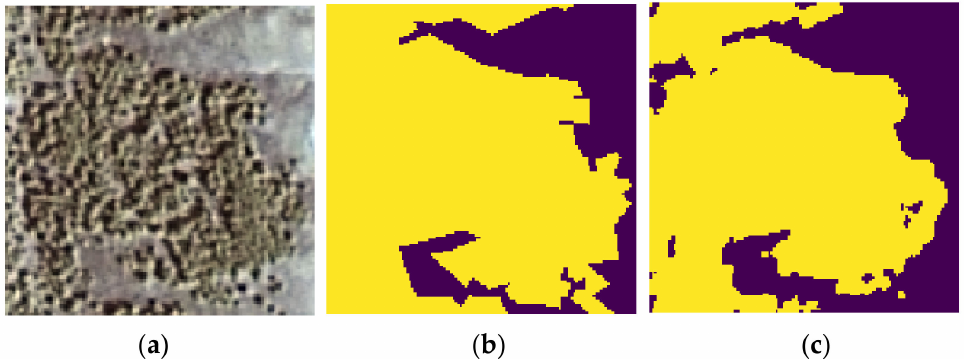
Figure 13. Figures of a random selected testing sample’ visualization: ( a ) false color composite image; ( b ) samples’ ground truth; ( c ) the segmentation results of the proposed